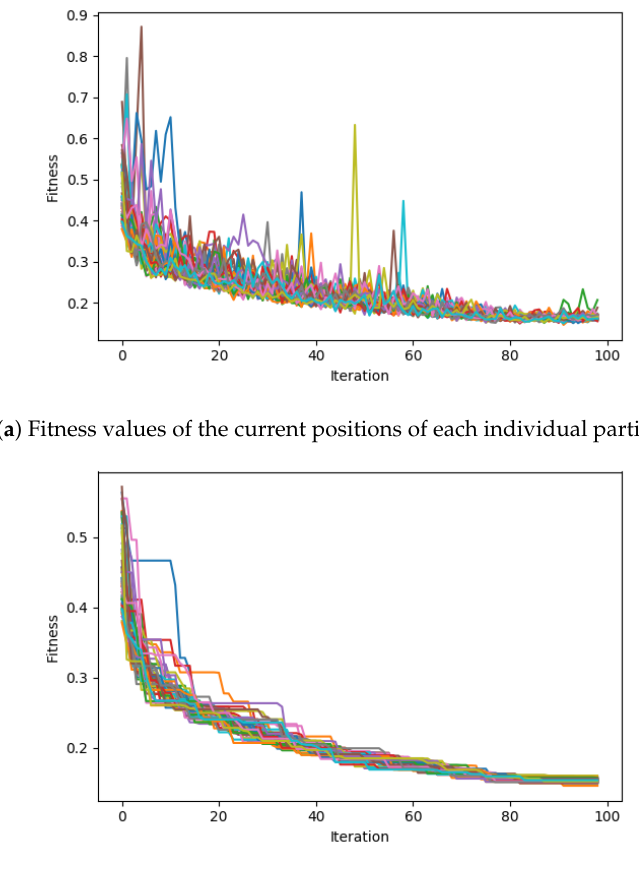
Figure 11. Fitness values for the current and local best positions of each individual particle throughout the optimisation process using the BLSK-S weight inheritance